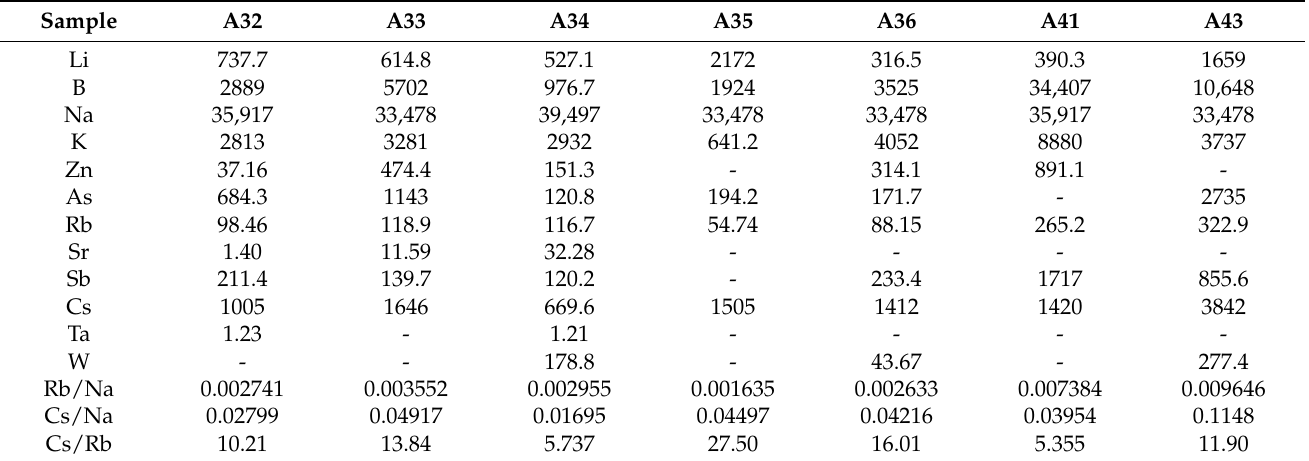
Table 2. LA-ICP-MS in situ analysis of fluid inclusions in beryl of Dakalasu No. 1 pegmatite vein (ppm).